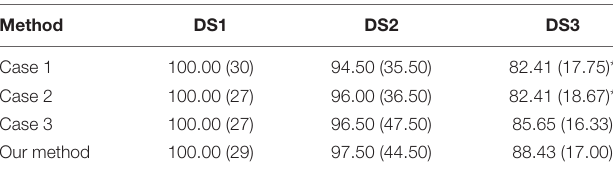
TABLE 4 | The average character recognition accuracy (%) (number of channels) comparisons on three datasets.